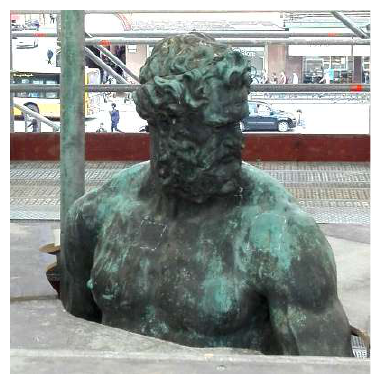
Figure 2. Neptune statue during the restoration works (detail).